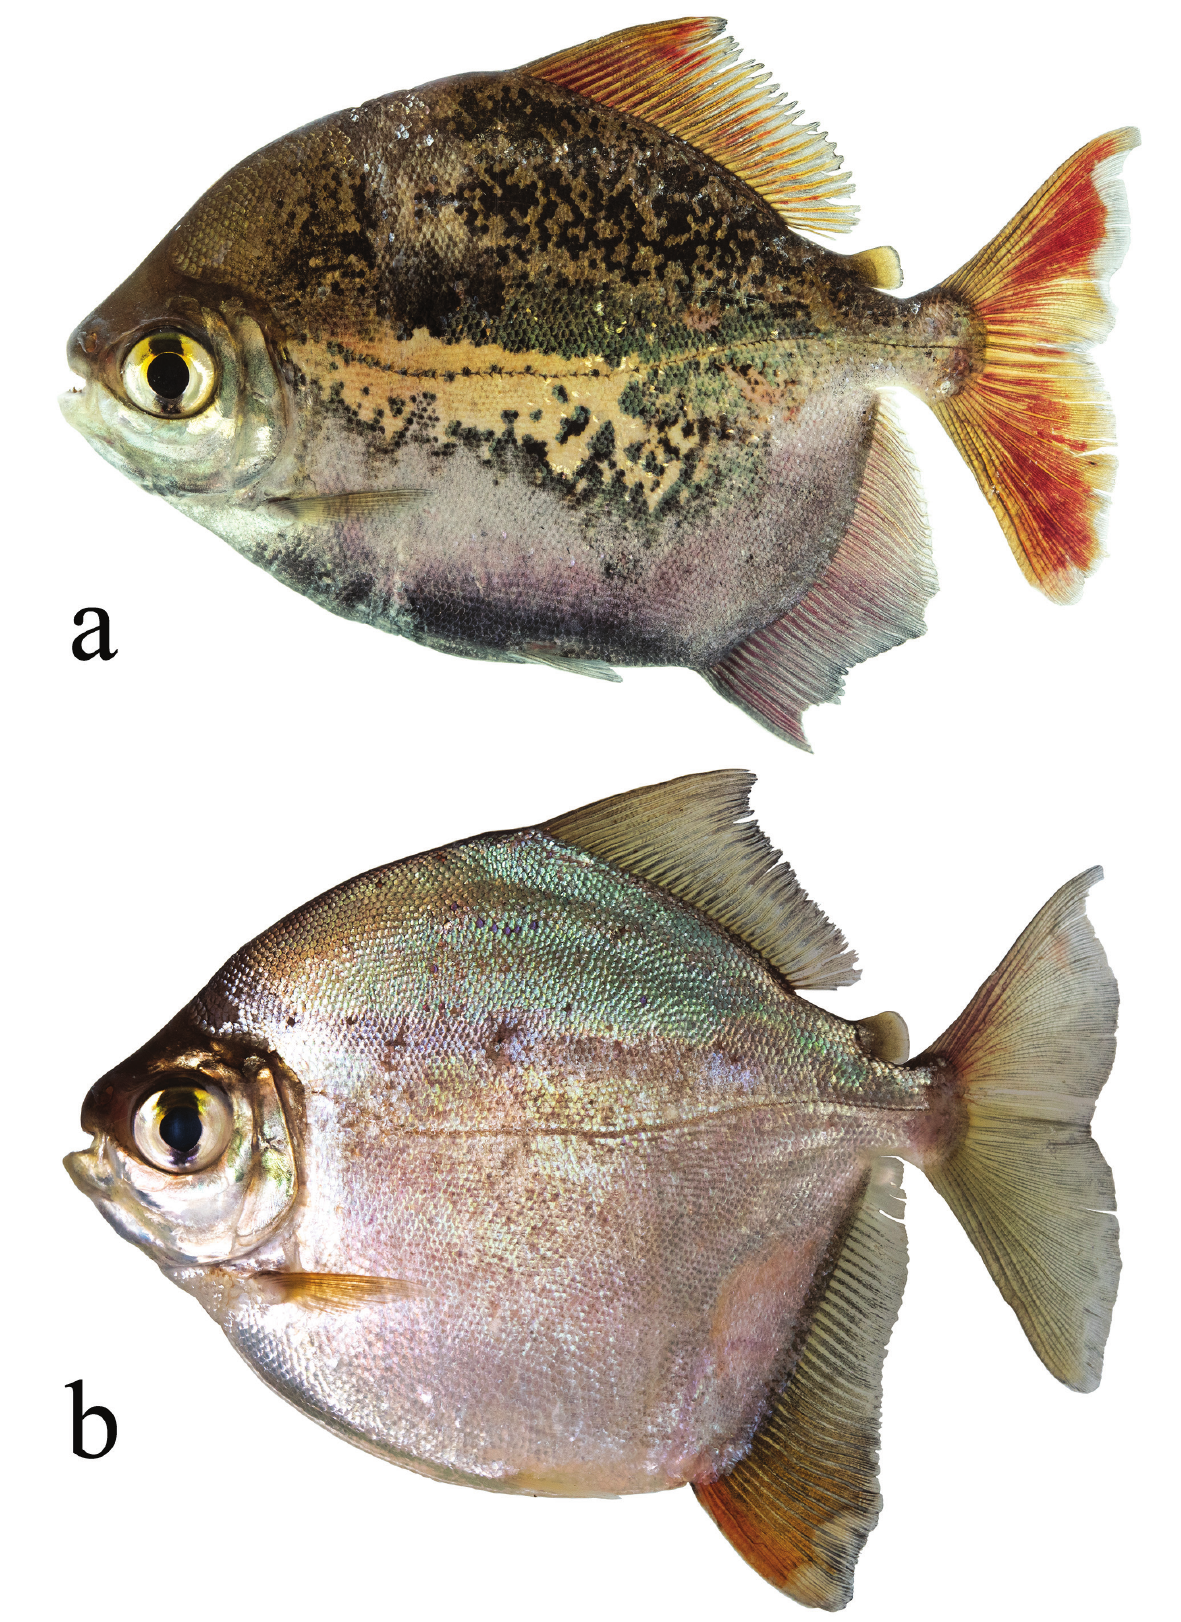
Fig. 3. Myloplus taphorni photographed shortly after capture. a. Male, paratype, UMMZ 251911, male, 154.9 mm SL, Guyana, Eping creek. b. Female, paratype, ROM 101262, 142.4 mm SL, Guyana, Lower Kurupung River. Photos: